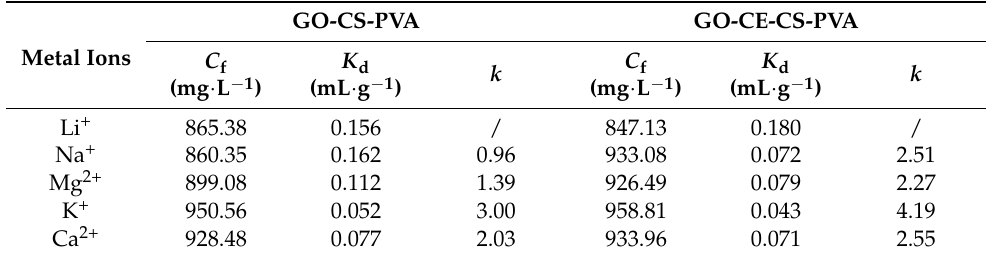
Table 4. The selective adsorption parameters of GO–CE–CS–PVA and GO–CS–PVA for Li + and other ions.